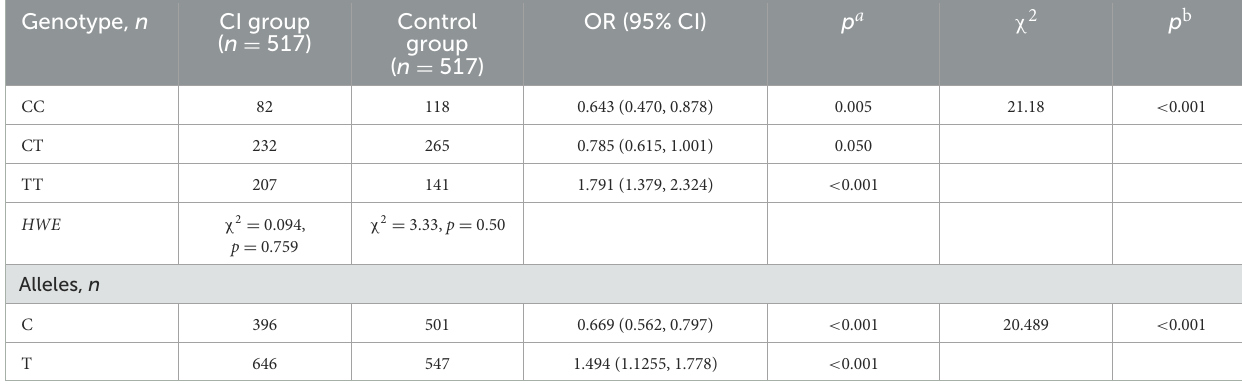
TABLE 3 The distributions of genotypes and alleles of the MTHFR C677T gene among CI patients and